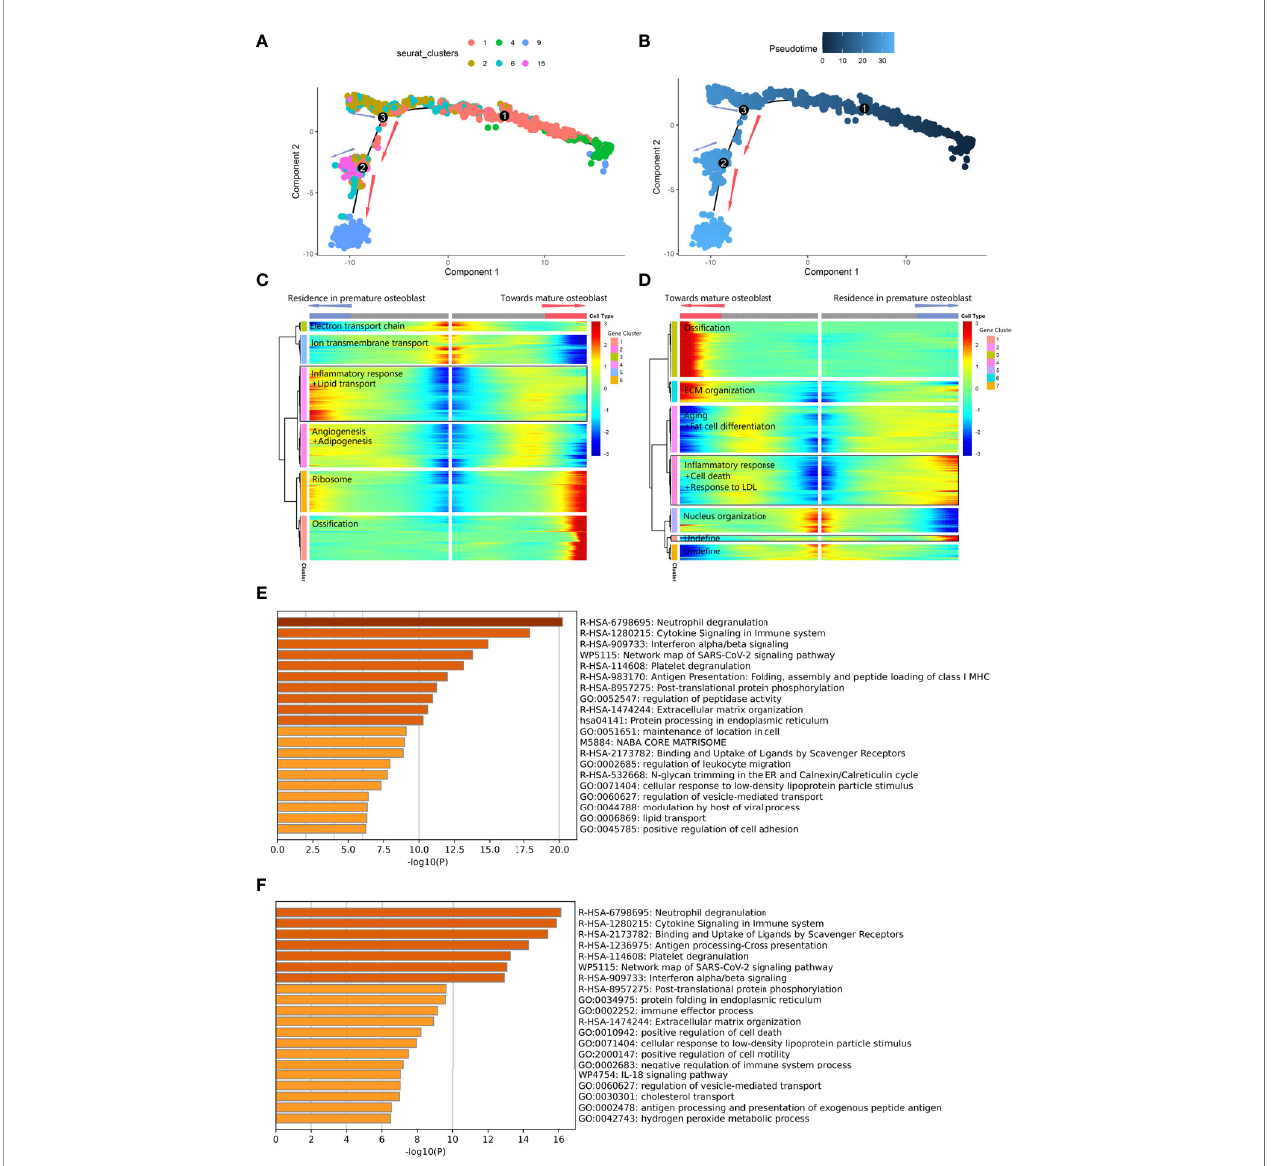
FIGURE 4 | Differentiated trajectory of osteoblast lineage cells. (A, B) Scatter plot showing the pseudotime trajectory in the osteoblast lineage. (A) is colored with cell clusters, and (B) is colored with pseudotime orders. The blue arrow indicates delayed transition in premature osteoblasts. The red arrow indicates the transition toward mature osteoblasts. (C, D). Heatmap plot showing gene expression alterations along the branch at node 3 (C) and node 2 (D) on the pseudotime trajectory tree. Red indicates high expression, and blue indicates low expression. The black box indicates the highly expressed gene cluster in the premature osteoblast branch. (E) Bar plot for the top-ranked gene set enrichment in the highly expressed gene cluster in the premature osteoblast branch at node 3. (F) Bar plot for the top-ranked gene set enrichment in the highly expressed gene cluster in the premature osteoblast branch at node